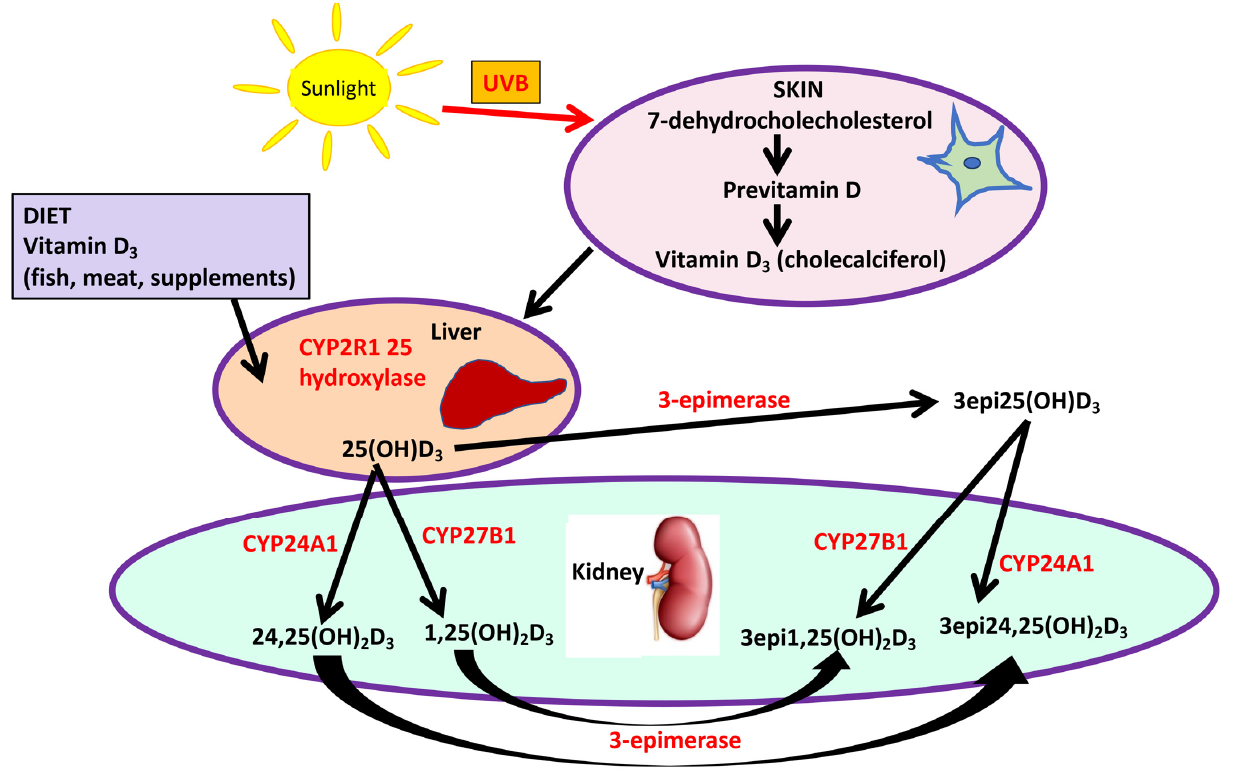
Figure 1. A schematic illustrating the sources (diet and sunlight) and metabolism in skin, liver and kidney of vitamin D 3 metabolites.